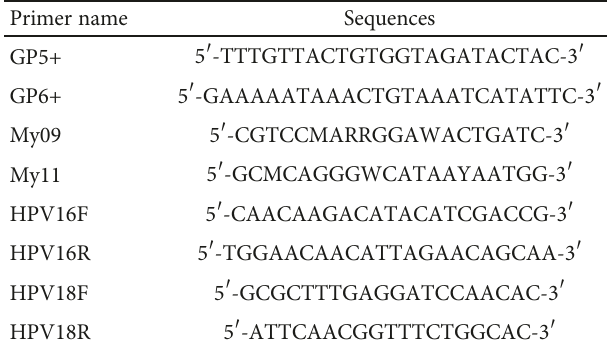
Table 1: The general primer sets for HPV DNA